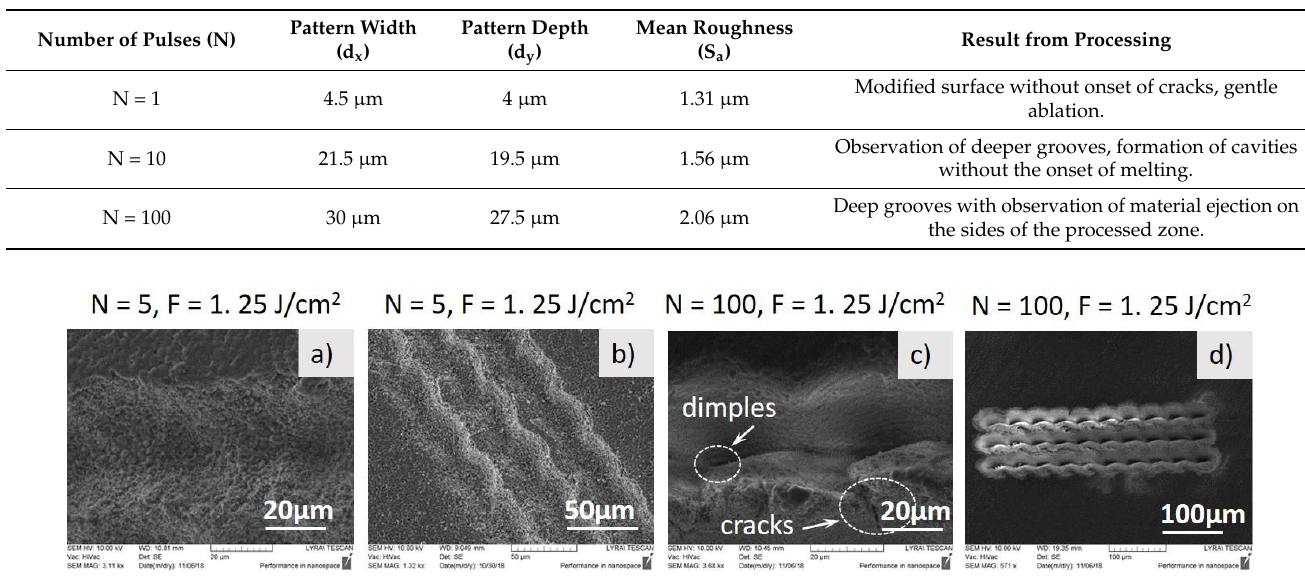
Table 1. Correlation between used processing parameters and dimensions of the obtained surface patterns in the spot by spot scanning regime.